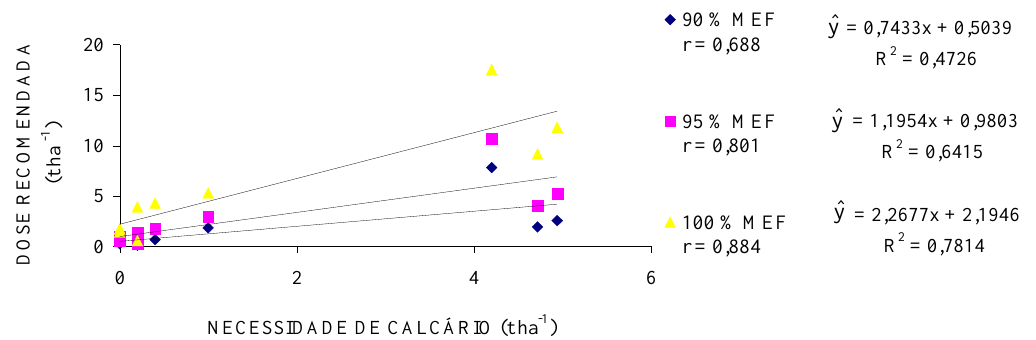
(MEF).Figura 3. Relação entre as necessidades de calcário, pelo método baseado no alumínio trocável, e as